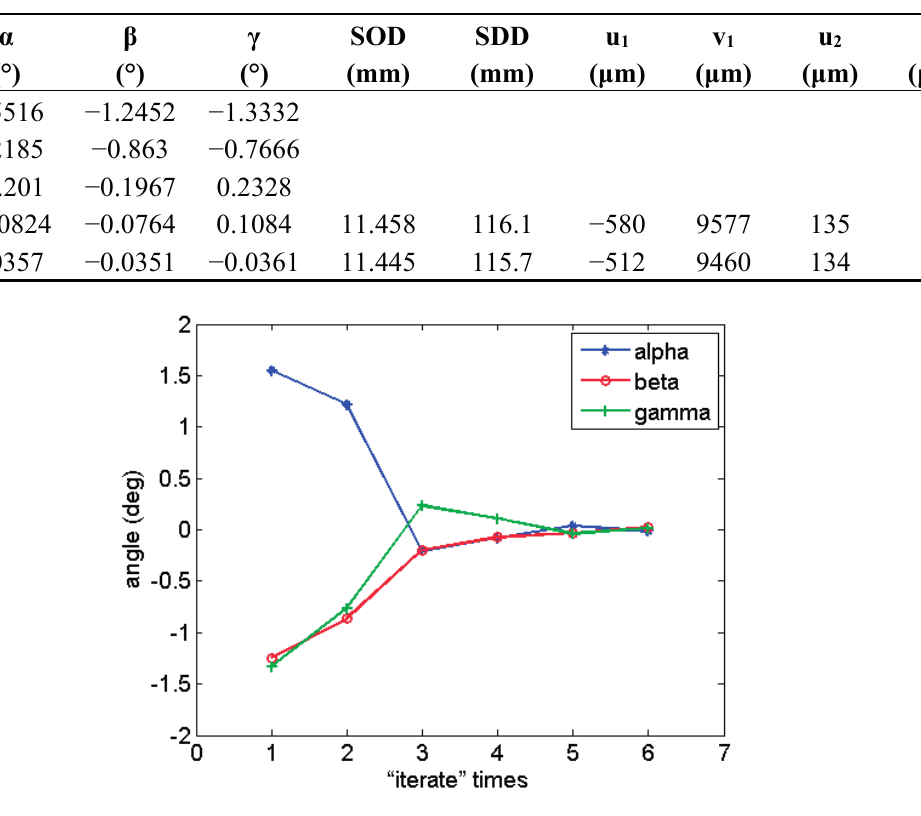
Figure 7. The values of the three angles varying with the “iterate” times.